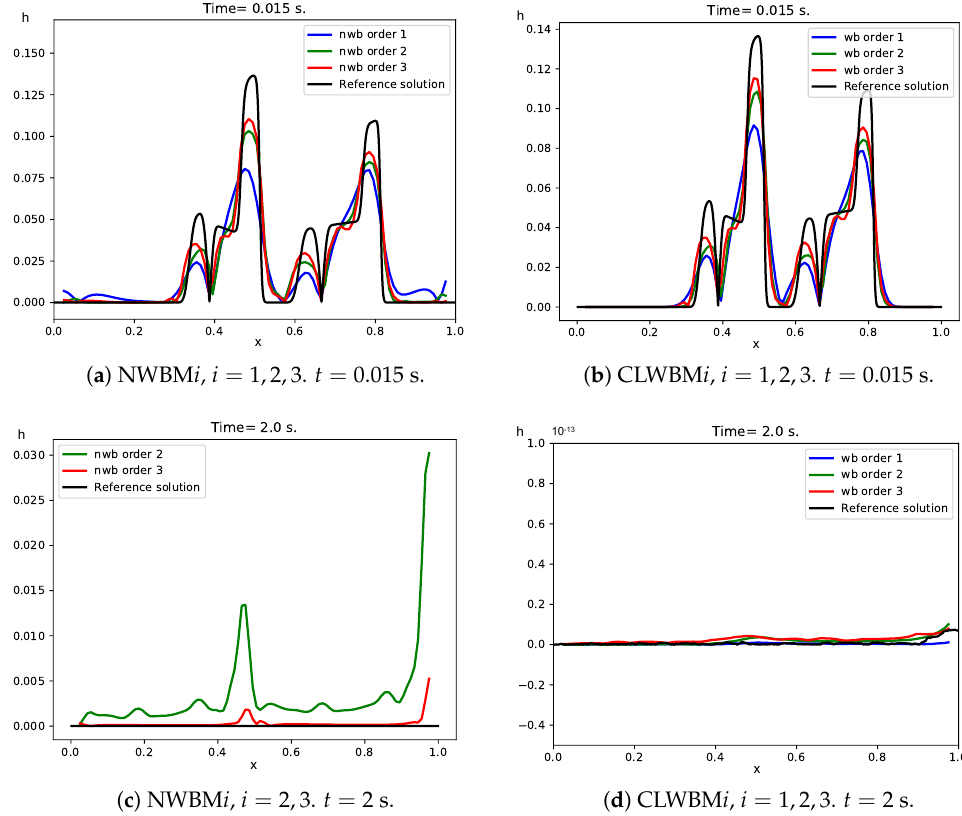
Figure 13. Test 4.4. Reference and numerical solutions: differences with the stationary solution at times t = 0.015,2 s for h , for a 100-cell mesh.